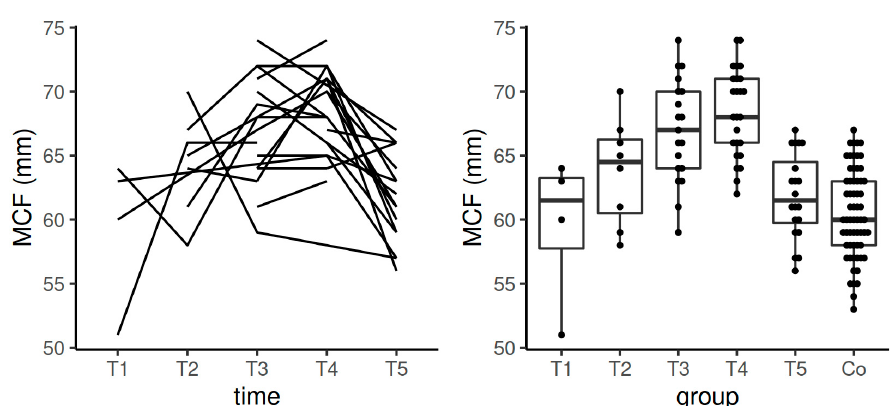
Figure 8. Spaghetti plot of the data from the longitudinal study ( left ), and swarmplot with boxplot of the same data together with the data from the control group ( right )—the results of MCF in INTEM. Legend: Co—control group, MCF—maximum clot firmness, T1—time interval 1, T2—time interval 2, T3—time interval 3, T4—time interval 4, T5—time interval 5.